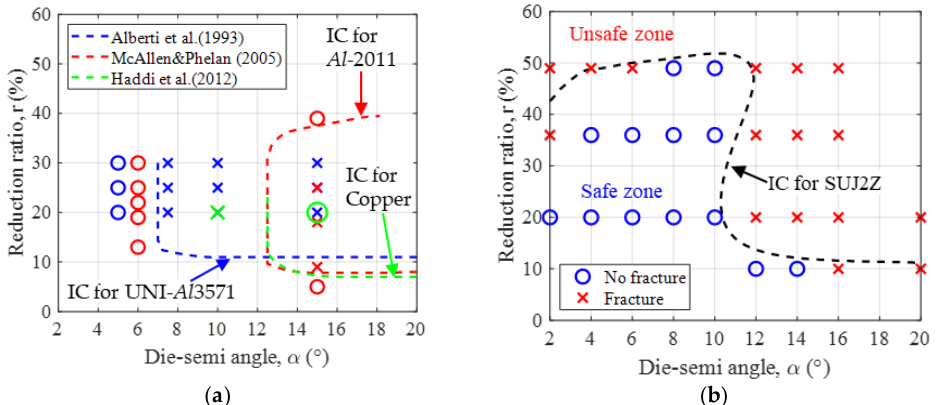
Figure 5. ( a ) Drawing limit diagrams (DLDs) reported in references [9,11,13] are analyzed for comparison purposes (reproduced). ( b ) DLD of SUJ2Z. Safe (no fracture) and unsafe (fracture) zones are distinguished by an identification curve (IC).